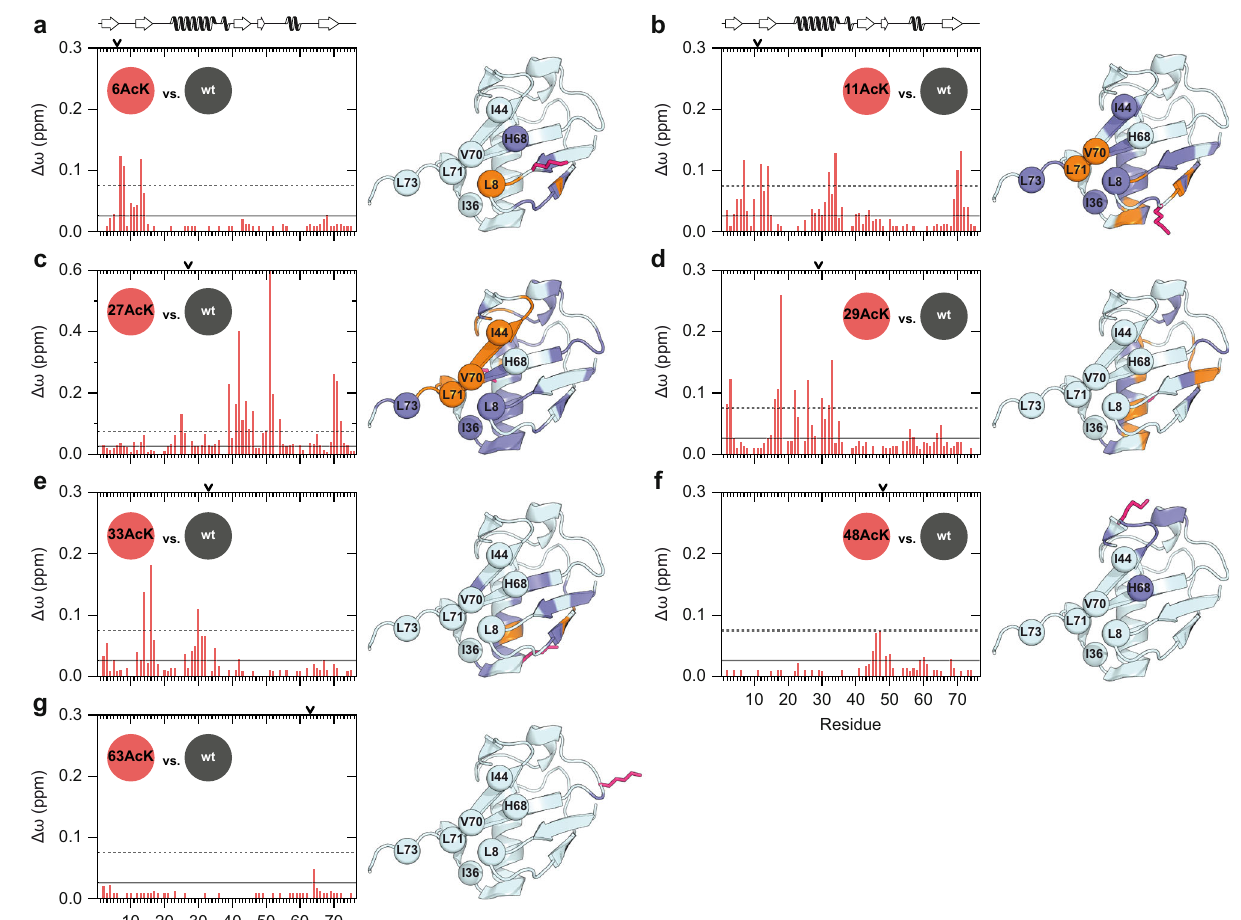
Fig. 2 | Site-speci fi c Ub acetylation results in distinct structural changes. a – g Weighted chemicalshiftperturbation (CSP, Δω ) mappingsofbackbone amide resonances are shown comparing the different mono-acetylated Ub variants each with nonmodi fi ed Ub (wt). CSP plots are depicted on the left for Ub 6AcK ( a ), Ub 11AcK ( b ), Ub 27AcK ( c ), Ub 29AcK ( d ), Ub 33AcK ( e ), Ub 48AcK ( f ), and Ub 63AcK ( g ),whereassigni fi cant Δω valuesarehighlightedontheNMRsolutionstructureof nonmodi fi edUb(wt)(PDBID1D3Z) 79 presentedincartoonmodeontheright.Note the different scaling used in the CSP mapping of Ub 27AcK in c in contrast to the other graphs. The cutoff values are the same in all plots and were calculated by taking the mean (horizontal solid line) and the mean plus one standard deviation